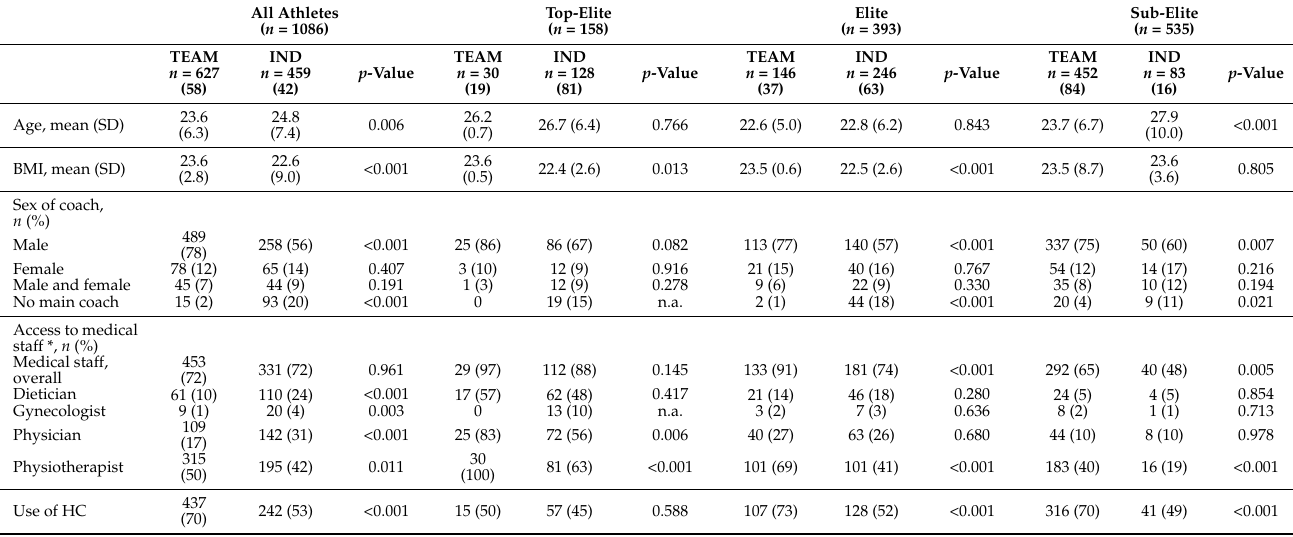
BMI = body mass index, TEAM = team player athlete, IND = individual competitive athlete, HC = hormonal contraceptives. * Medical staff includes chiropractor, dietician, gynecologist, mental coach, masseur, naprapathy, physiotherapist, physician, and physical trainer. n.a. = not